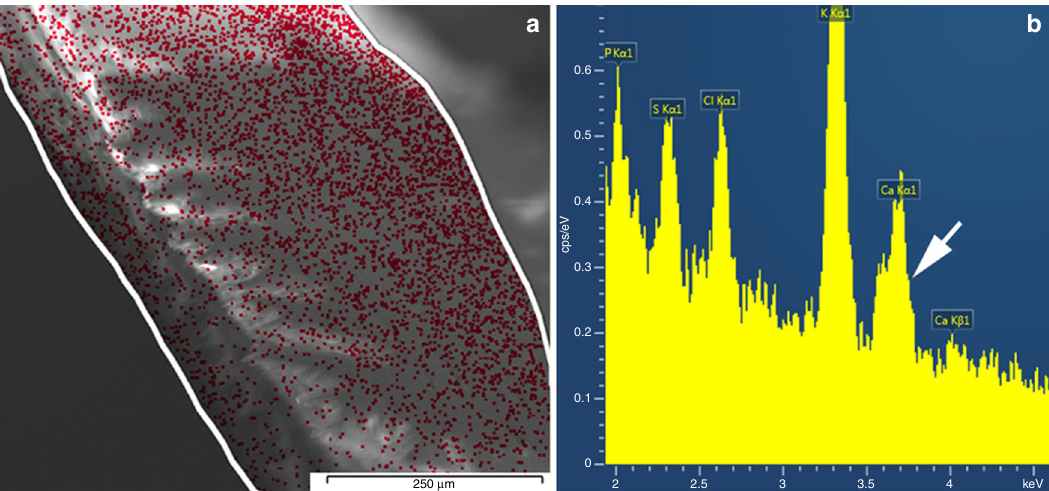
Fig. 6 SEM image and spatial distribution of Ca along lateral head margin. a EDX analysis of the spatial distribution of Ca. b Typical EDX spectrum showing the presence of Ca (0.02 – 0.04 atomic